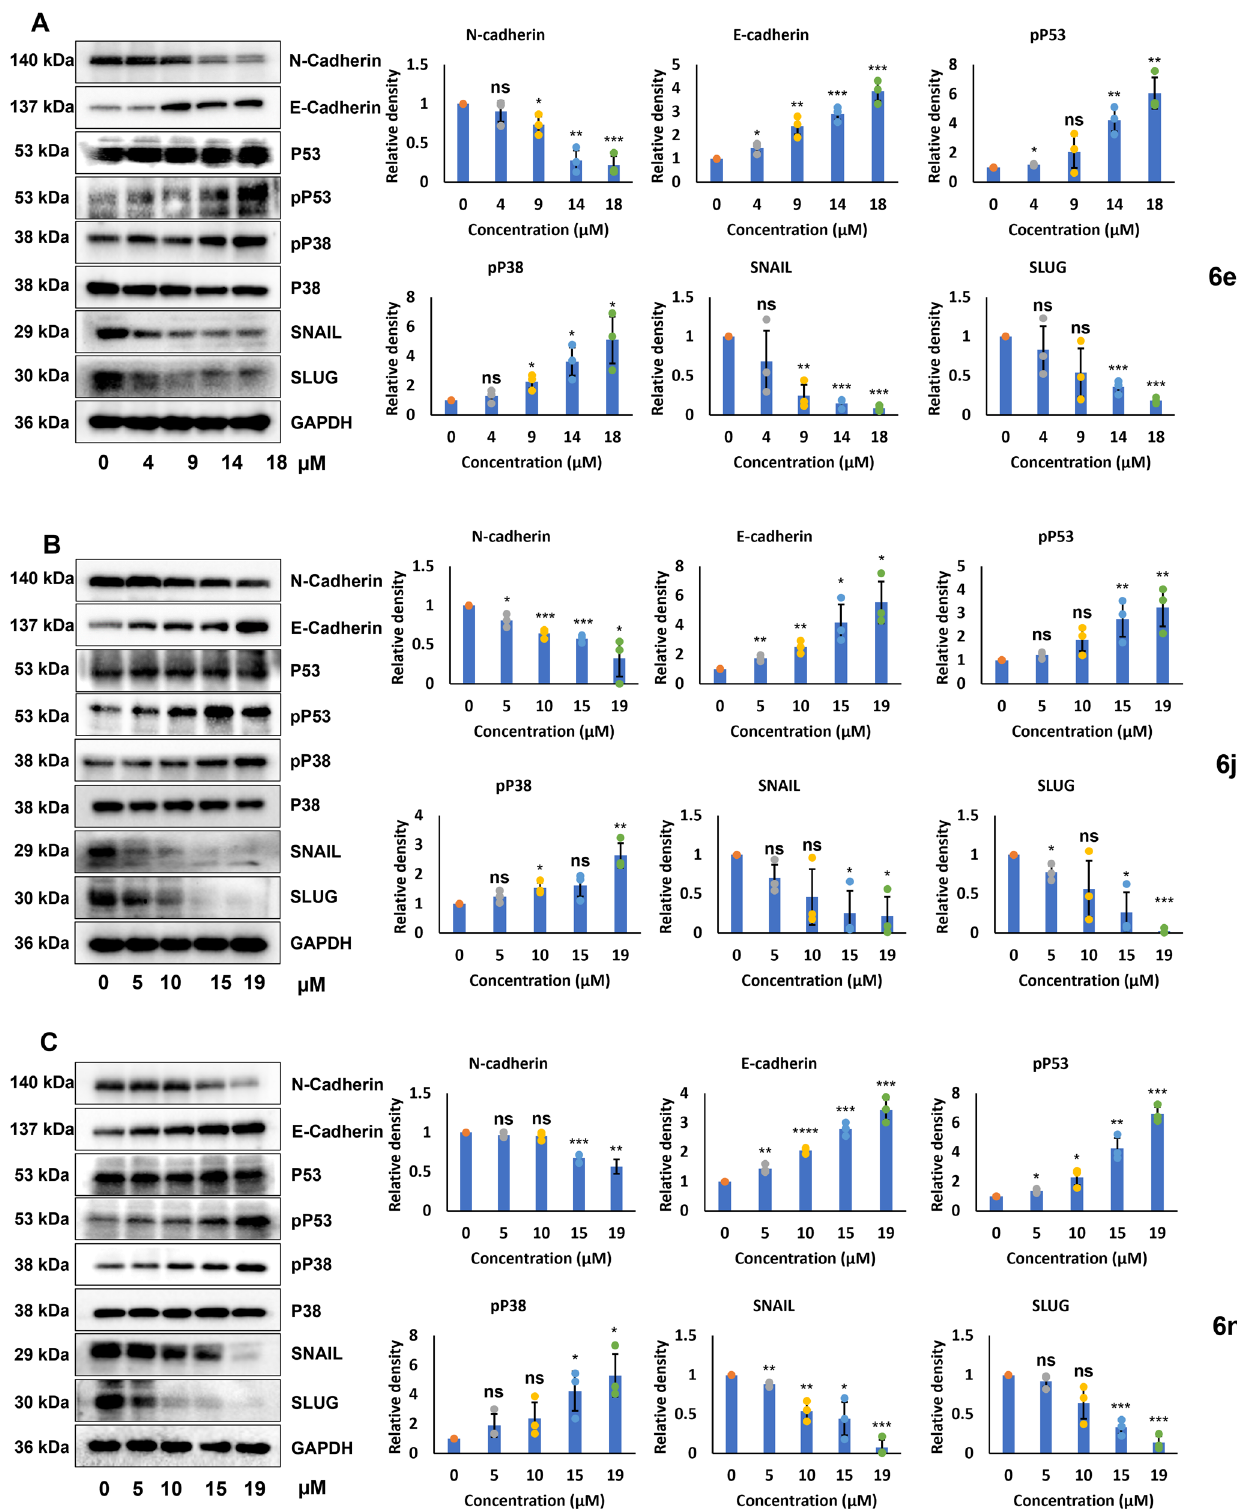
Fig. 9 cATC derivatives 6e, 6j and 6n activate pro-apoptotic signaling and suppress expression of EMT markers in HeLa cells. A – C Western blot analysis of cellular lysates prepared from HeLa cells treated with varying concentrations (0 – 19 µ M) each of 6e ( A ), 6j ( B ) and 6n ( C ). Left panel shows Western blot images for E-Cadherin, N-Cadherin, total P53, phospho-P53, phospho-P38, total P38, SNAIL and SLUG. GAPDH was used as loading control. Bar graphs in right panel show mean ± SD average value of three experiments for densitometric analysis relative to GAPDH. Difference in expression level was analyzed compared to 0 µ M (DMSO only) using two-tailed unpaired Student ’ s t test. ns represents non-signi fi cant, * represents p -value ≤ 0.05, ** represents p -value ≤ 0.01, *** represents p -value ≤ 0.001, **** represents p -value ≤ 0.0001, and, N represents experiment